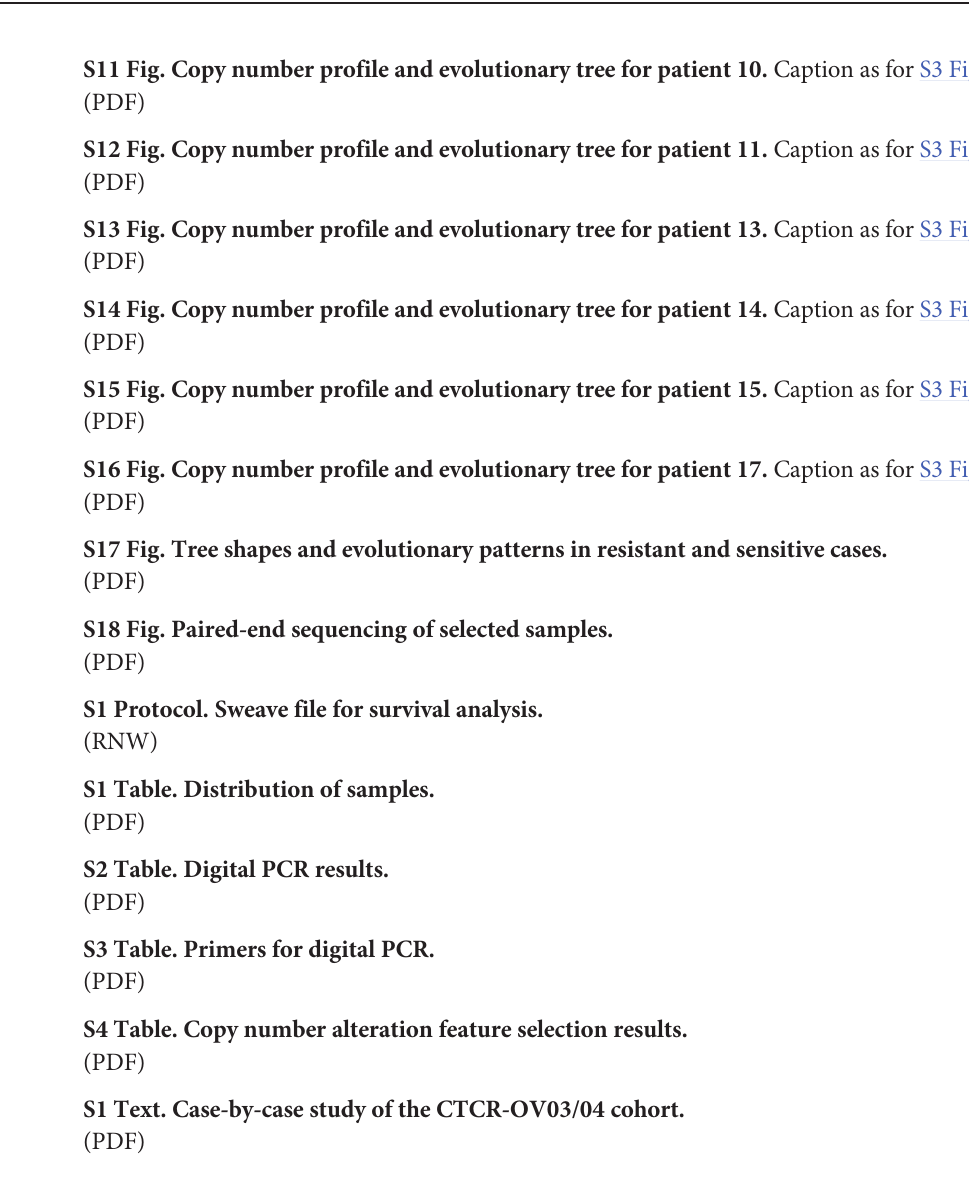
S4 Table. Copy number alteration feature selection